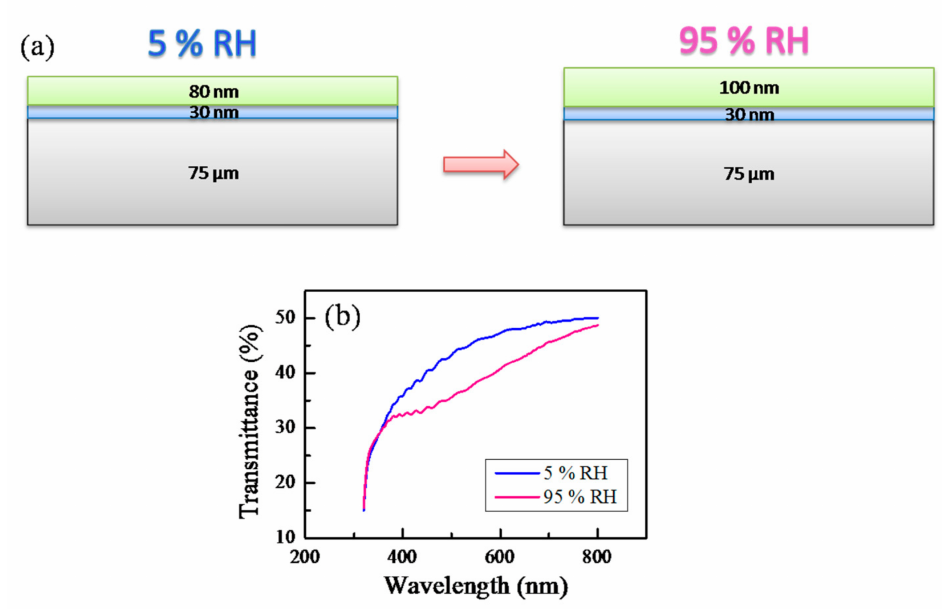
Figure 7. Scheme of the effect of the humidity on the sensor’s structure ( a ) and transmittance spectra at low and high humidity levels ( b